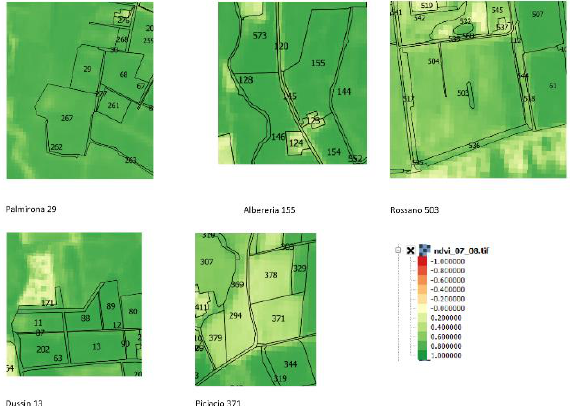
Figure 6. Mowed PP class in each testing